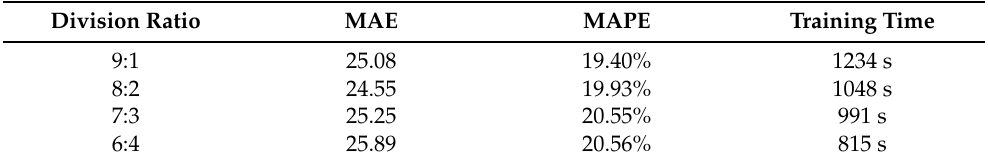
Table 2. Evaluation of model performance with different data division ratio with lstmunits set to 64 and epochs set to 10.